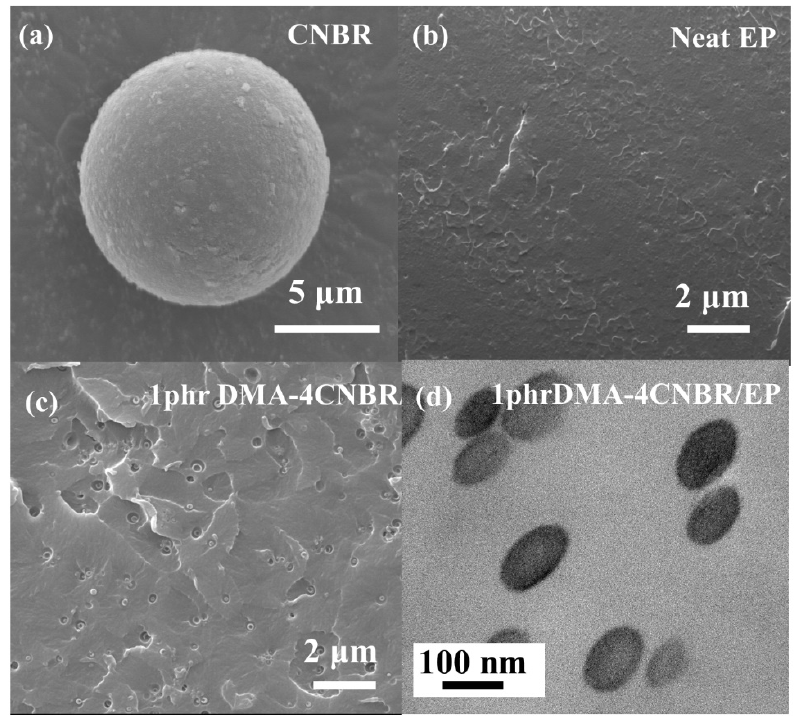
Figure 1. SEM ( a ) morphology of CNBR. SEM ( b , c ) and TEM ( d ) morphology of neat epoxy coating and 1phr DMA-4CNBR/EP coating cross-section.